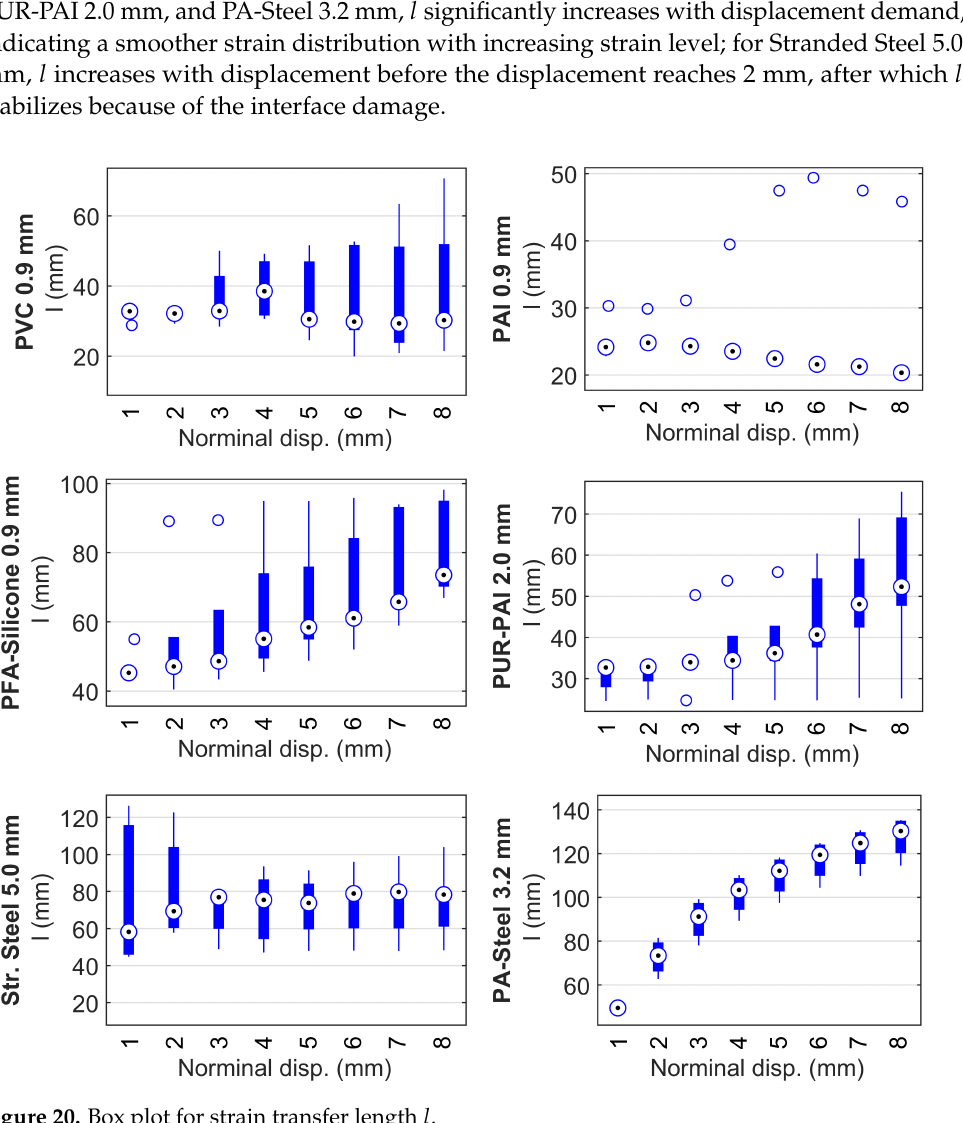
Figure 20. Box plot for strain transfer length l